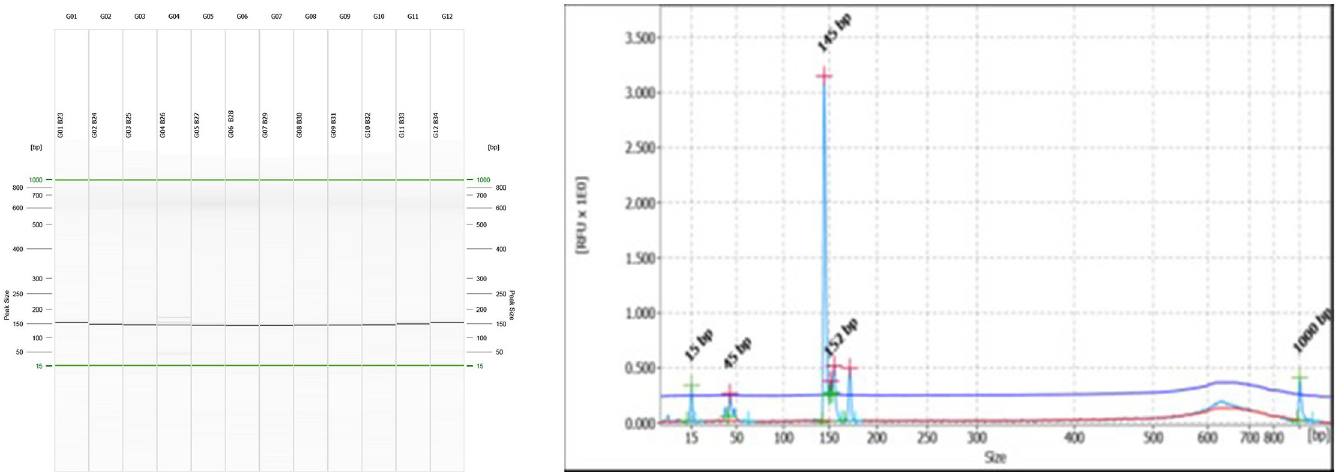
Fig 4. Validation of SSR markers in germplasm accessions of ginger. A. Gel image of PCR amplification of SSR marker ZOSSR25 on 48 germplasm accessions of ginger as captured on QIAxcel ScreenGel software. Numbers refer to accession numbers as indicated in S1 Table. The last lane is DNA molecular weight standard 50- 1000bp v2.0 Qx DNA size marker. B. A representative electropherogram showing different allele sizes (sample G04 B26, variety Athira).